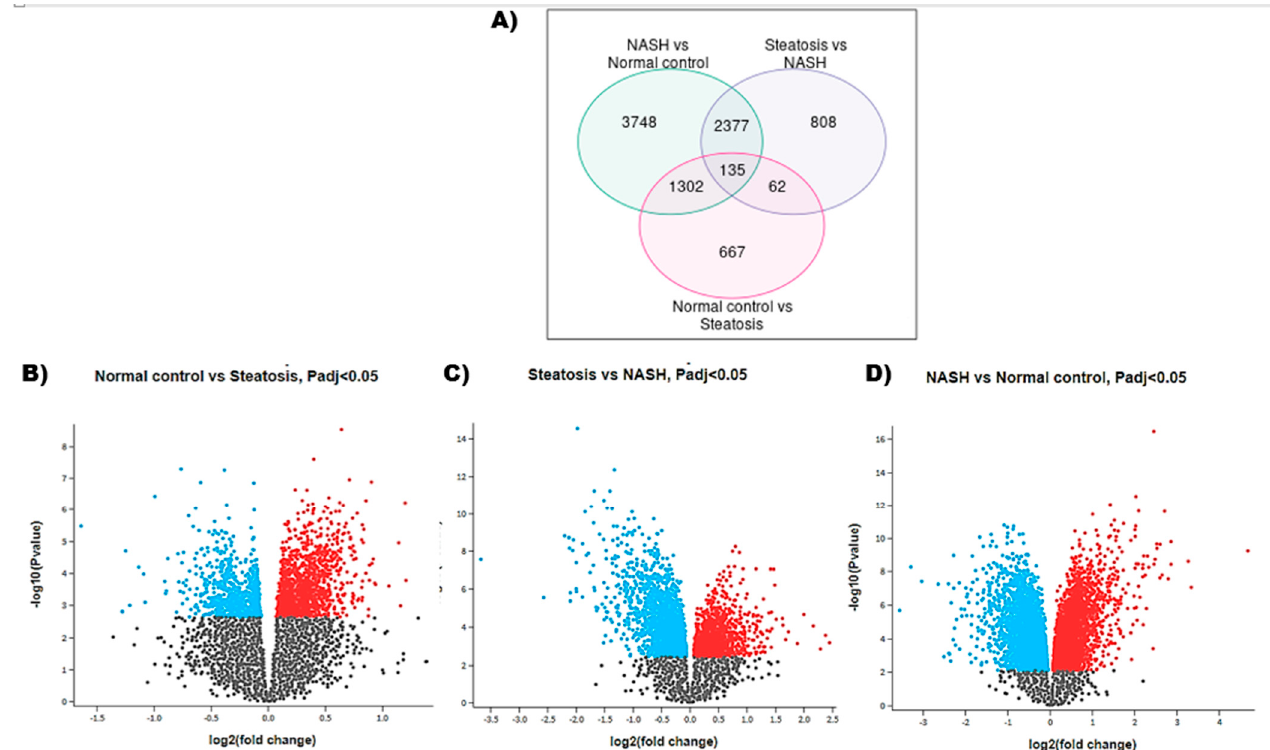
Figure 1. DEGs in GSE33814 dataset. ( A ) Venn diagram for DEGs between the three comparison groups. ( B – D ) Volcano plots of differentially expressed mRNAs between the three comparison groups. Red dots represent upregulated genes, blue dots represent downregulated genes, and black dots represent insignificantly differentially expressed genes, Padj < 0.05. DEG, differentially expressed gene; NASH, non-alcoholic steatohepatitis.